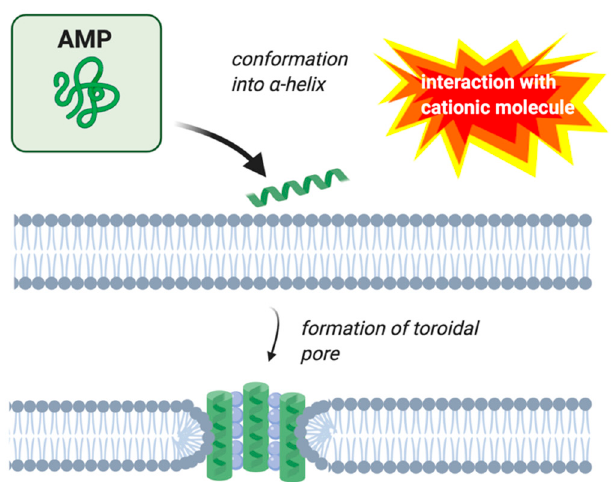
Figure 2. Membrane permeation by the toroidal pore model. AMPs are indicated by green helices. Image created with